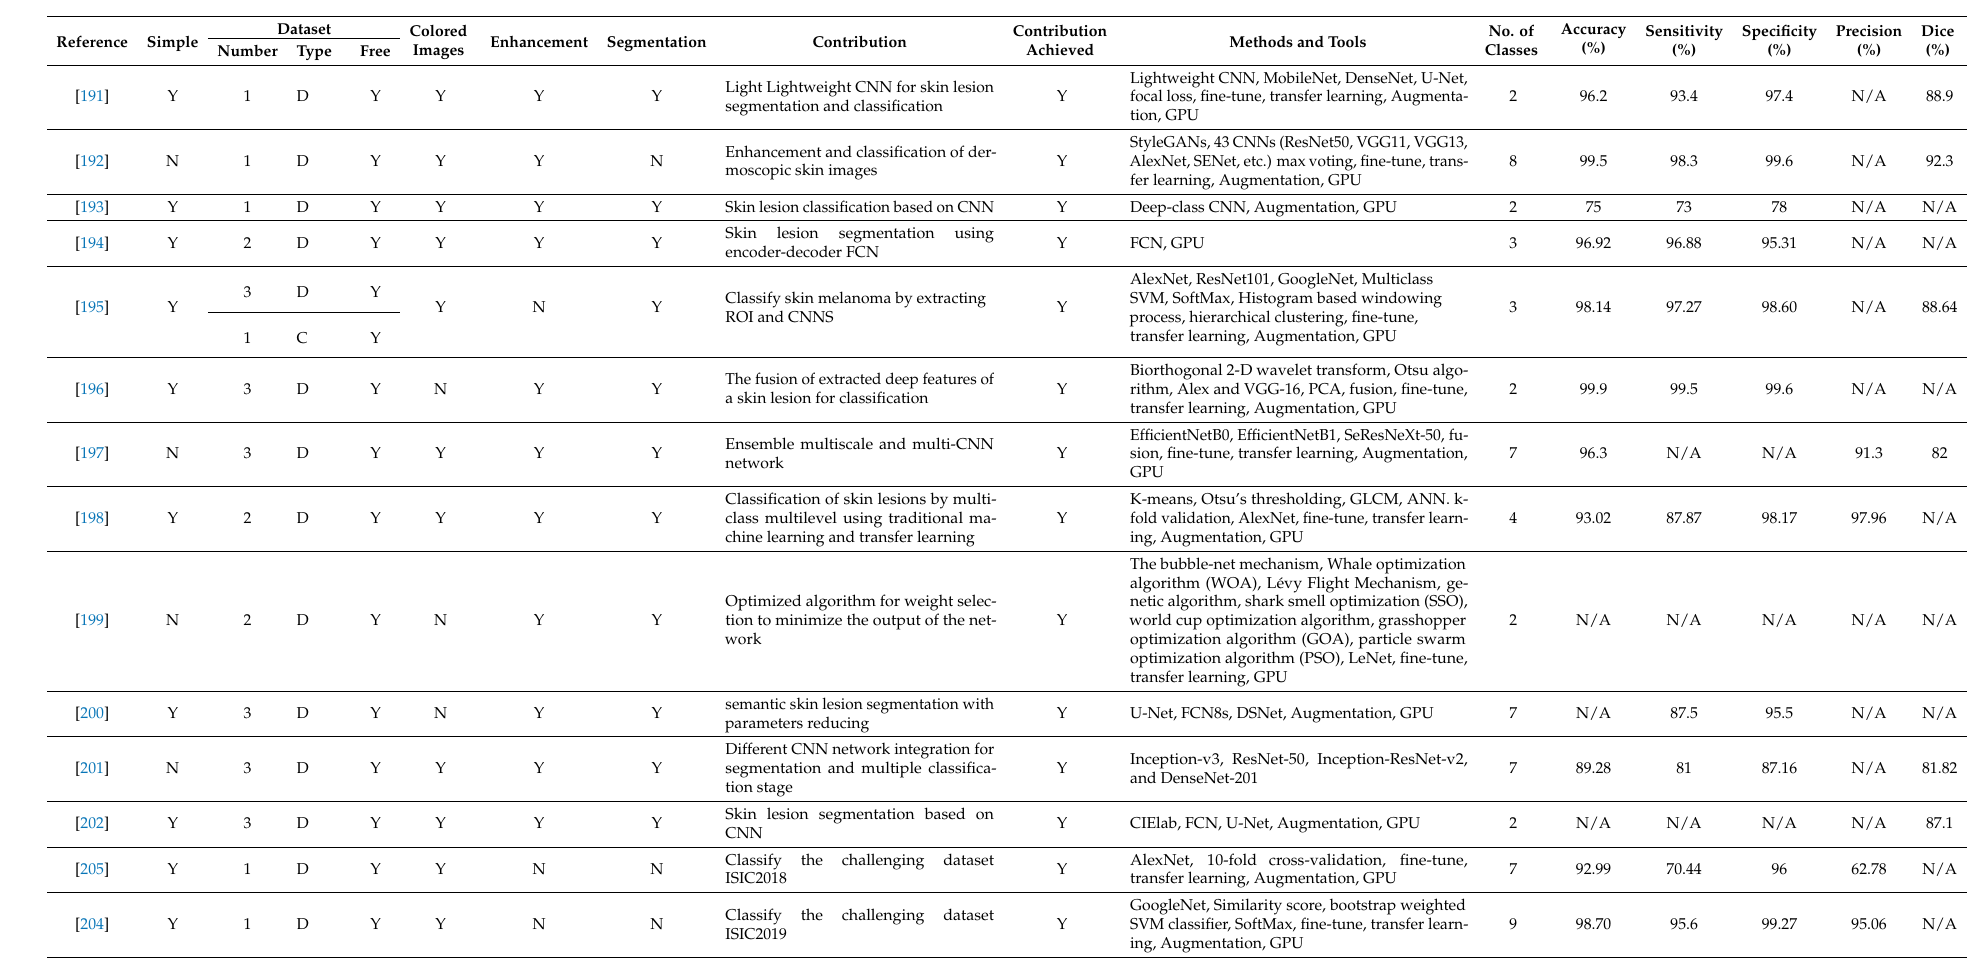
netic algorithm, shark smell optimization (SSO), world cup optimization algorithm,